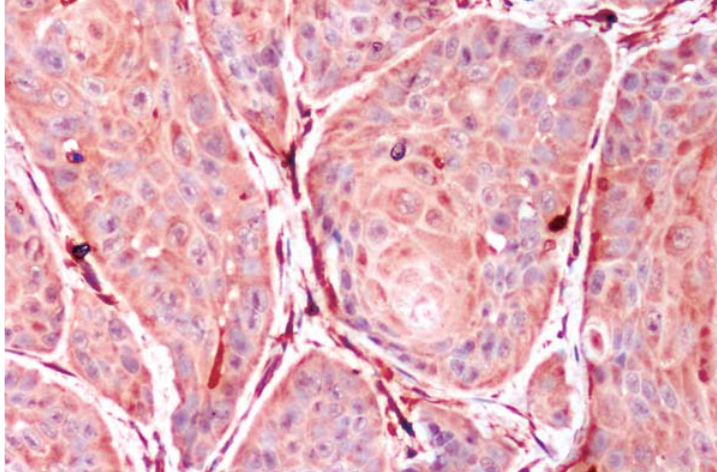
Figure 3- Oral squamous cell carcinoma (OSCC) showing type 3 pattern of invasion with groups of cells with no distinct borderline (S100A4, 20x)